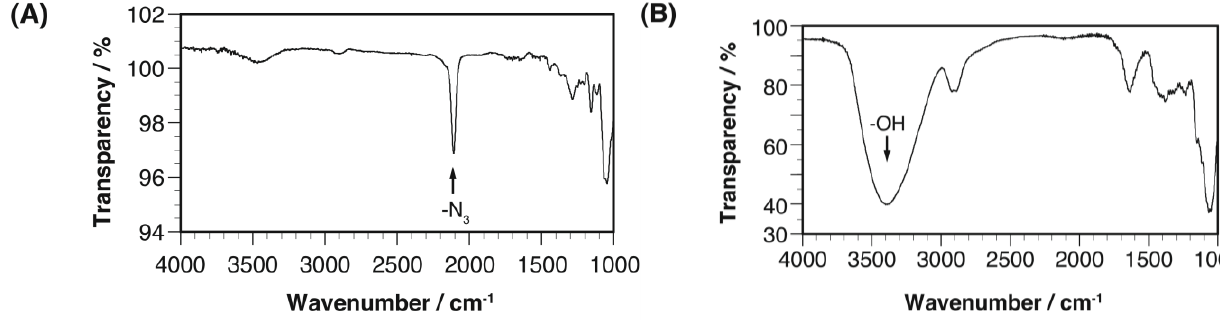
Figure 3. IR spectra of ( A ) Cel-N